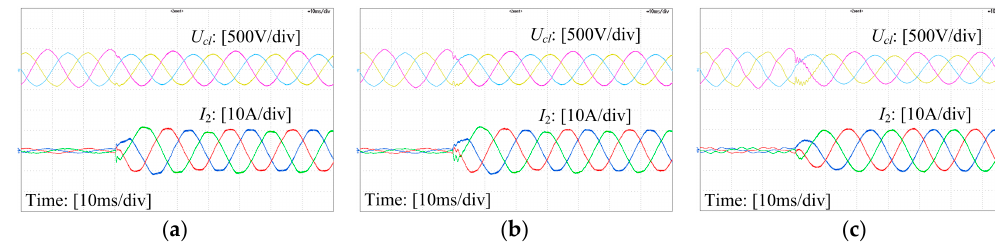
Figure 23. Experimental results of grid-connected converter starting in rectifier mode with DFPS-CVFF under unbalanced grid; ( a ) L ’ g = 0; ( b ) SCR = 10; ( c ) SCR = 2.